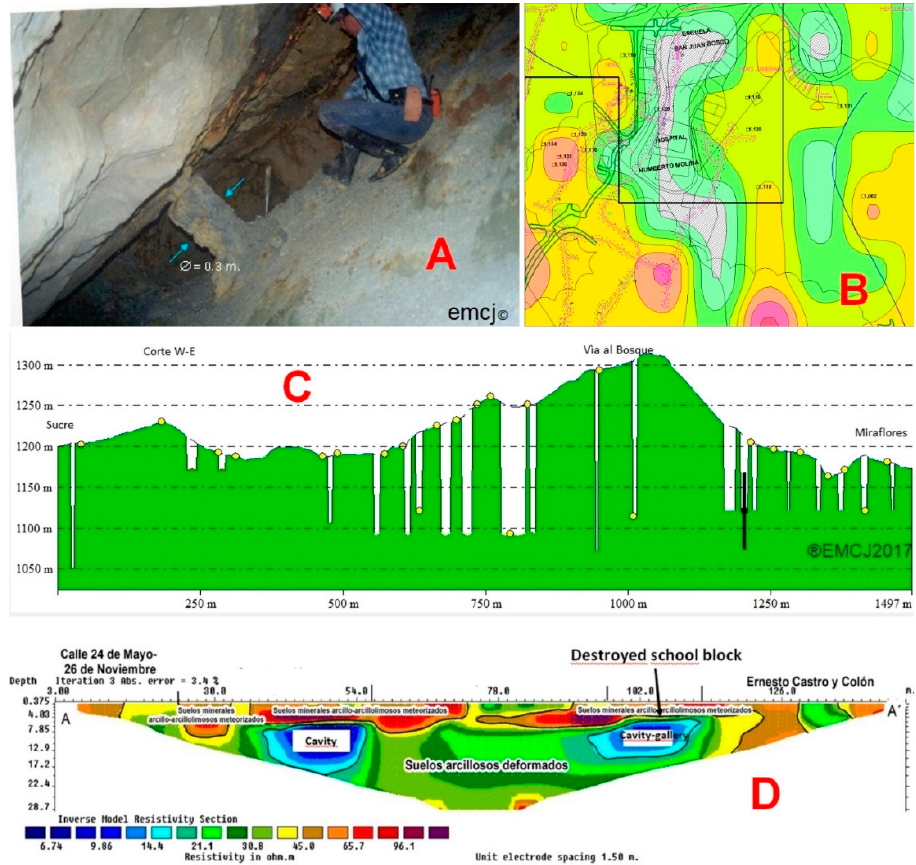
Figure 2. ( A ) Pillars exploited and destroyed, without resistance to the load of the upper rock and soil that in the sector reaches more than 50 meters thick. ( B ) Sinking dating back to 2001 using the flow pattern technique and morphological rupture lines. ( C ) W–E Topographic profile and subsidence caused by mining galleries in underground projection to the top of the galleries. ( D ) Electrical tomography of the subsoil in the streets May 24, November 26, Ernesto Castro, Colon and Gonzalo Pizarro. The collapse of the La Immaculada-Fé y Alegría school block was possibly due to the instability caused by the underground gallery that exists below (blue spot). This sinking was reactivated in 2019.